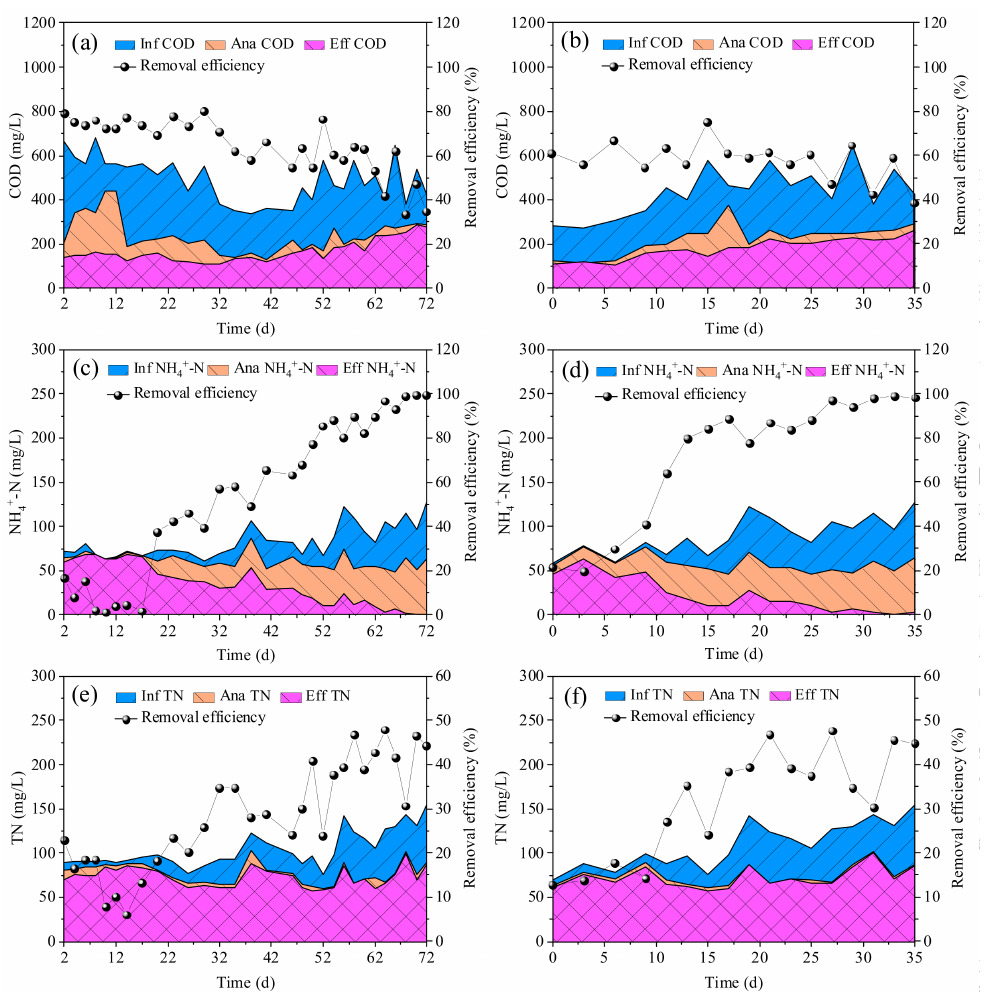
Figure 4. Variations of COD, NH 4 + -N, and TN in R1 ( a , c , e ) and R2 ( b , d , f ) throughout the operational